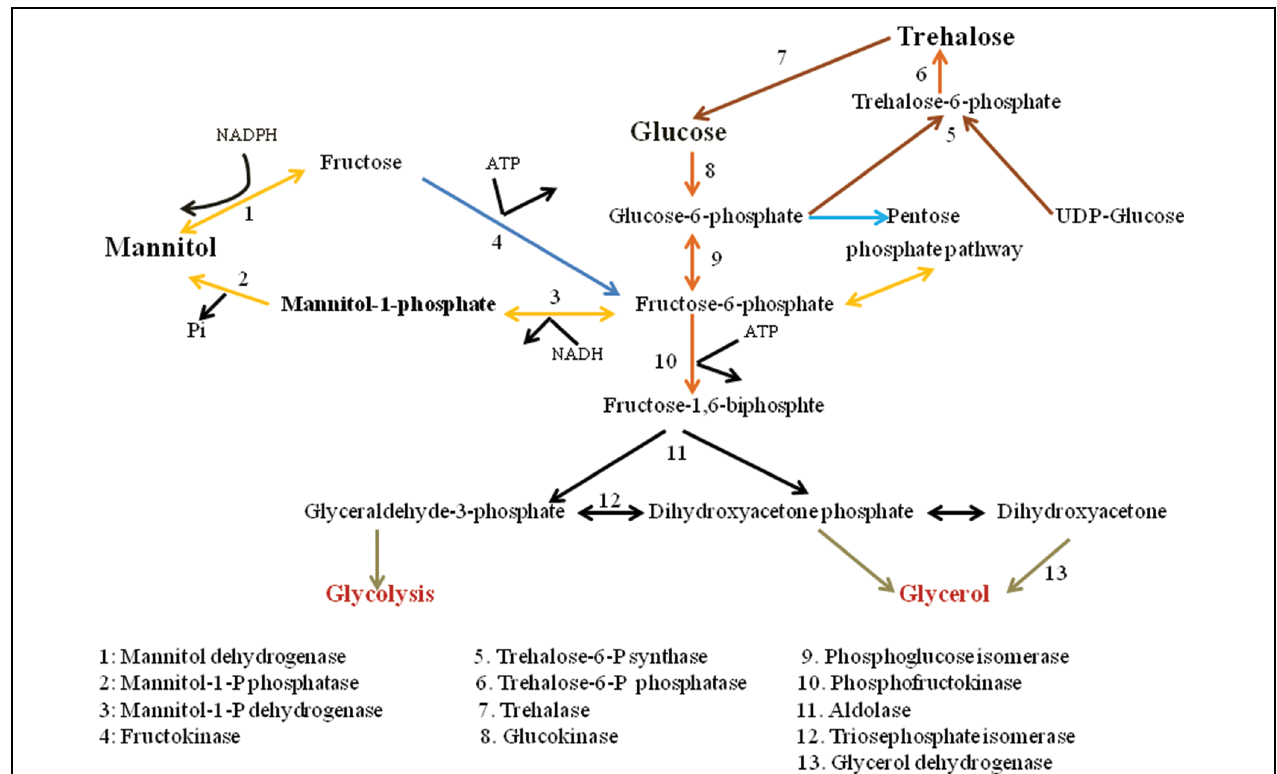
FIGURE 1 | Carbohydrate conversion and mannitol metabolic pathways in